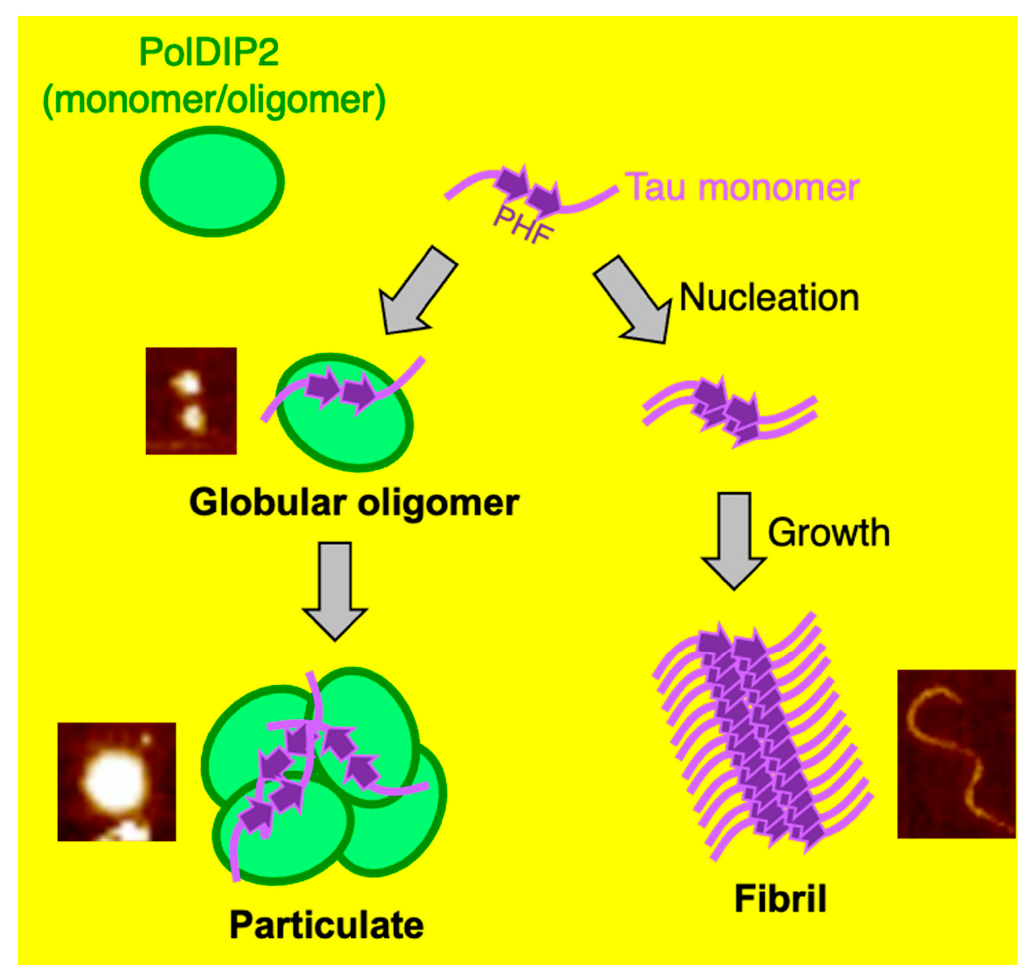
Figure 6. Summary of the PolDIP2-dependent inhibition of Tau aggregation. Tau is an unstructured protein, but in the presence of heparin, it forms oligomers that start fibril formation (nucleation), which then grow into longer fibrils (fibril growth). PolDIP2 interacts with the Tau monomer, and then it self-assembles into “globular oligomers”, which redirects its growth from linear to spherical assembly. The “globular oligomer” formation pathway is potentially behind the inhibition of the nucleation and fibril growth of Tau. Prolonged incubation of Tau with PolDIP2 leads to the formation of bigger round-shaped structures, termed